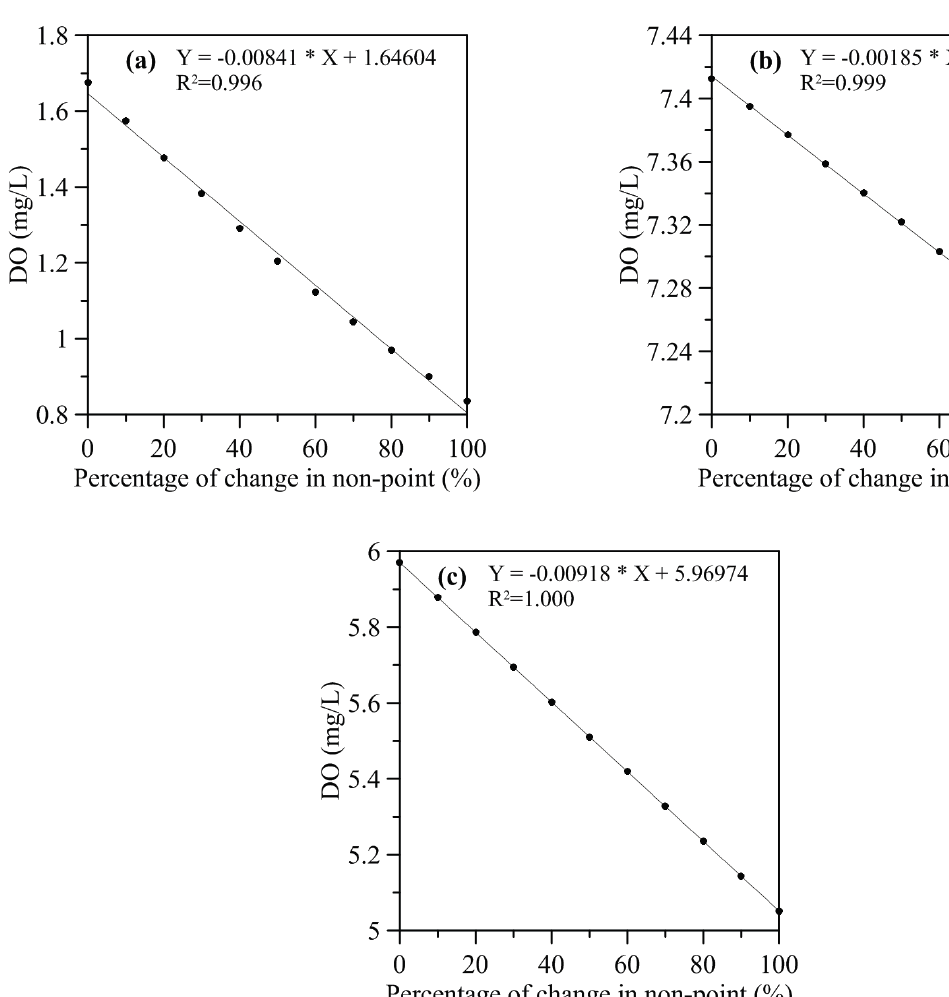
Figure 9. Predicting dissolved oxygen concentration for Scenario 1 at different locations: ( a ) Hsin-Hai Bridge; ( b ) Chung-Cheng Bridge; and ( c ) Nan-Hu Bridge. Note that the incremental ratio of the nonpoint source is 10% for each run. The black point and the solid line represent the model prediction and the regression line,